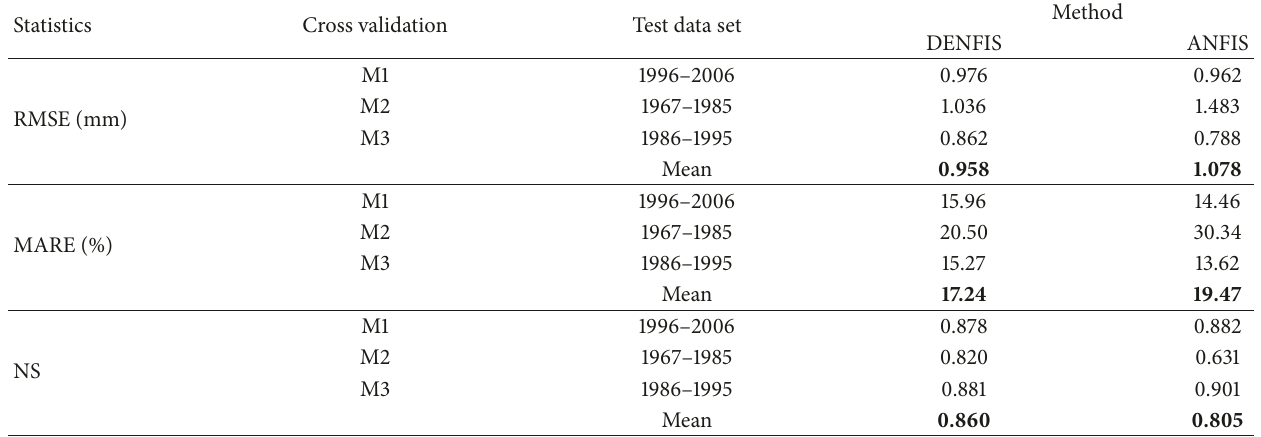
Table 3: Comparison of the DENFIS and ANFIS models in modeling pan evaporation—Antalya